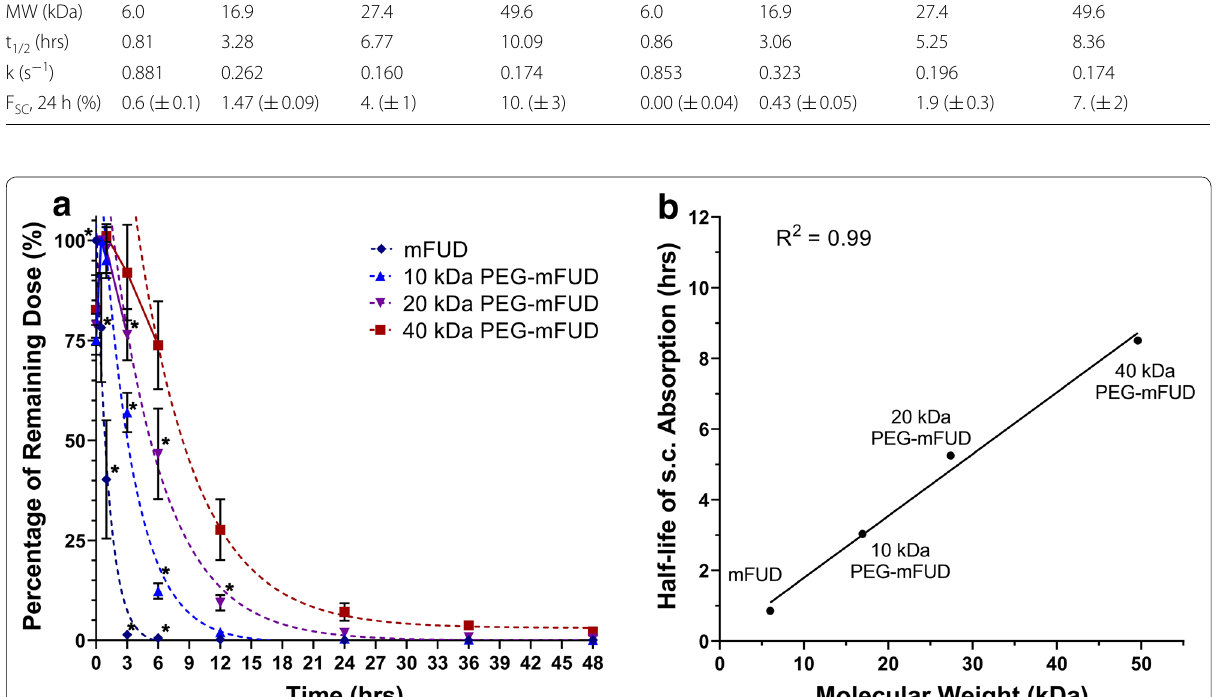
Fig. 9 a Percentage of drug dose (F SC %) remaining at the site of s.c. injection over time after administration of a mFUD or 10 kDa, 20 kDa, or 40 kDa PEG-mFUD and a sulfo-Cy5 conjugate dose between the shoulder blades of a mouse. A one phase decay function was applied to the terminal phase of the absorption to calculate F SC % 50% (t 1/2 ) values. Significance (p 0.05) of difference between mean F SC % values of a peptide and its = ≤ larger counterpart is denoted with an asterisk (*). n 3 b Relationship between apparent half-life (t 1/2 ) of peptide absorption and the peptide’s MW. = Linear regression analysis resulted in an r 2 correlation coefficient of